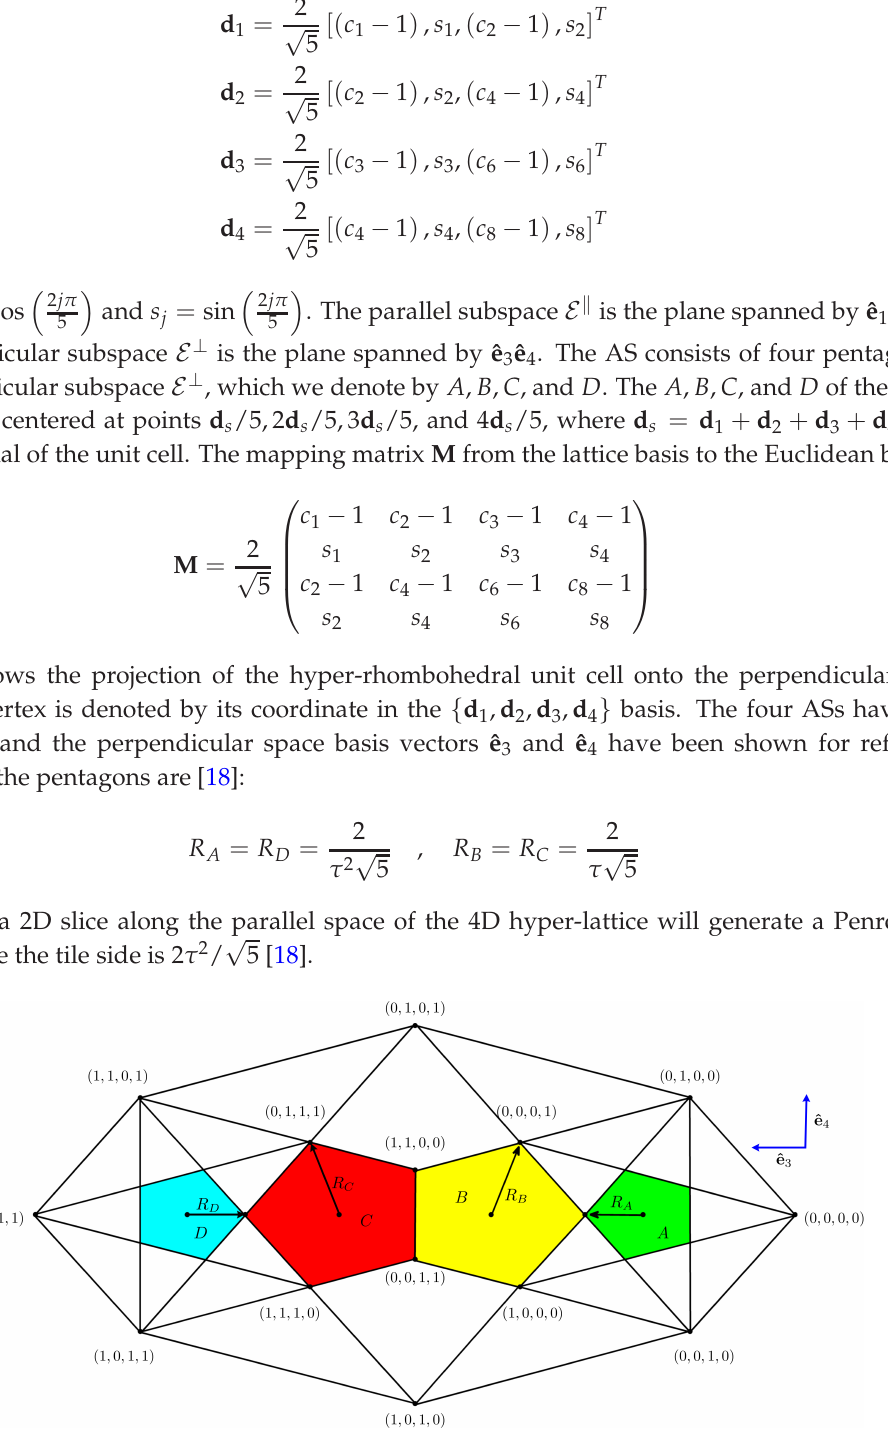
Figure 7. Projection of 4D hyper-rhombohedral unit cell onto the perpendicular space ASs have been highlighted, and the perpendicular space basis vectors ˆe 3 and ˆe 4 have been shown for